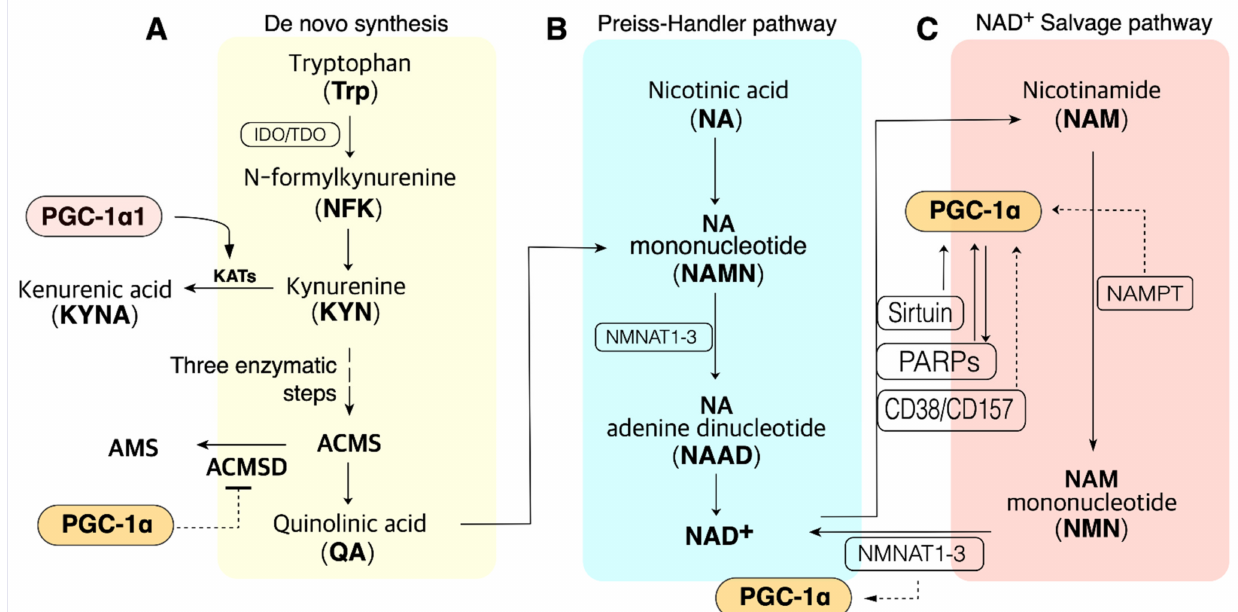
Figure 1. PGC-1 α is involved in the pathway of NAD + biosynthesis and consumption in the metabolic tissue such as muscle, liver, and adipose tissue. ( A ). NAD + de novo synthesis from Trp. PGC-1 α may promote QA synthesis via blocking ACMSD. PGC-1 α 1 may promote de novo synthesis via KAT activation. ( B ). NAD + biosynthesis from NA in the Preiss– Handler pathway; QA from de novo synthesis also can be synthesized to NAD + in the Preiss–Handler pathway. ( C ). PGC-1 α may influence many enzymes in the salvage pathway. ACMS, α -amino- β -carboxymuconate- ε -semialdehyde; ACMSD, ACMS decarboxylase; NAMPT, nicotinamide phosphoribosyltransferases (three isoforms exist); NMNAT, NMN adenylyltransferase; PARP, poly (ADP-ribose) polymerase. Dashed lines indicate additional evidence is required to reveal the